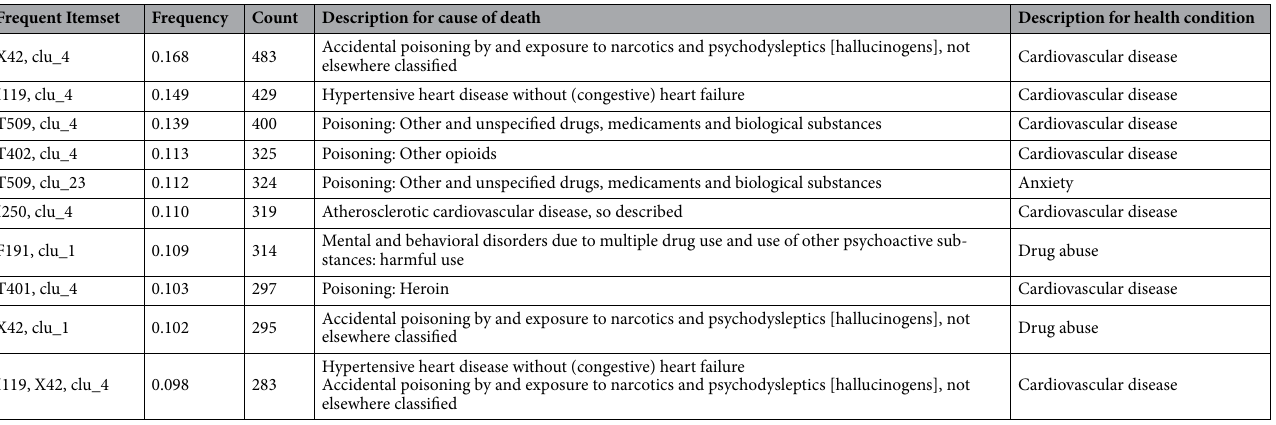
Table 1. List of top 10 most frequent results which have more than two items including one or more health conditions in frequent itemset. Cardiovascular disease was the most prevalent concomitant health condition in